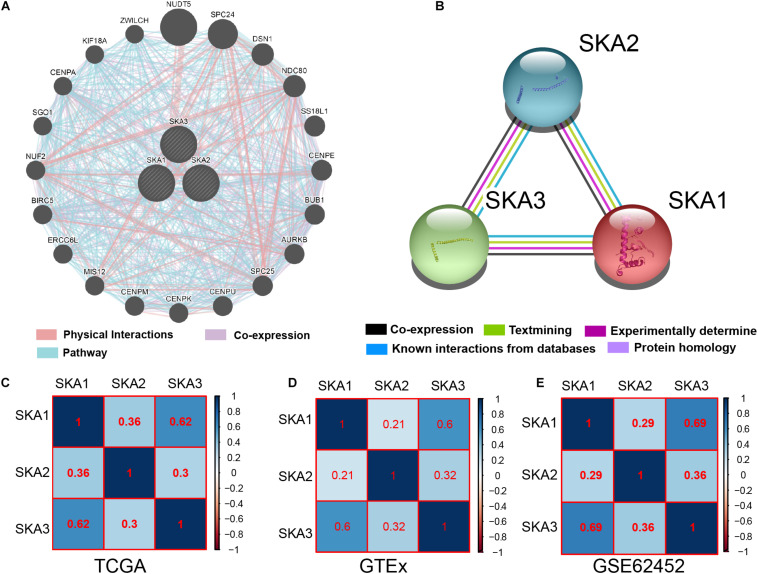
Interaction networks and co-expression matrix of spindle and kinetochore associated genes. (A) Gene–gene interaction network created using the Gene Multiple Association Network Integration Algorithm (GeneMANIA). (B) Protein–protein interaction network created using the Search Tool for the Retrieval of Interacting Genes/Proteins (STRING). (C–E) Co-expression matrix of SKA genes in TCGA, GTEx, and GSE62452 datasets.